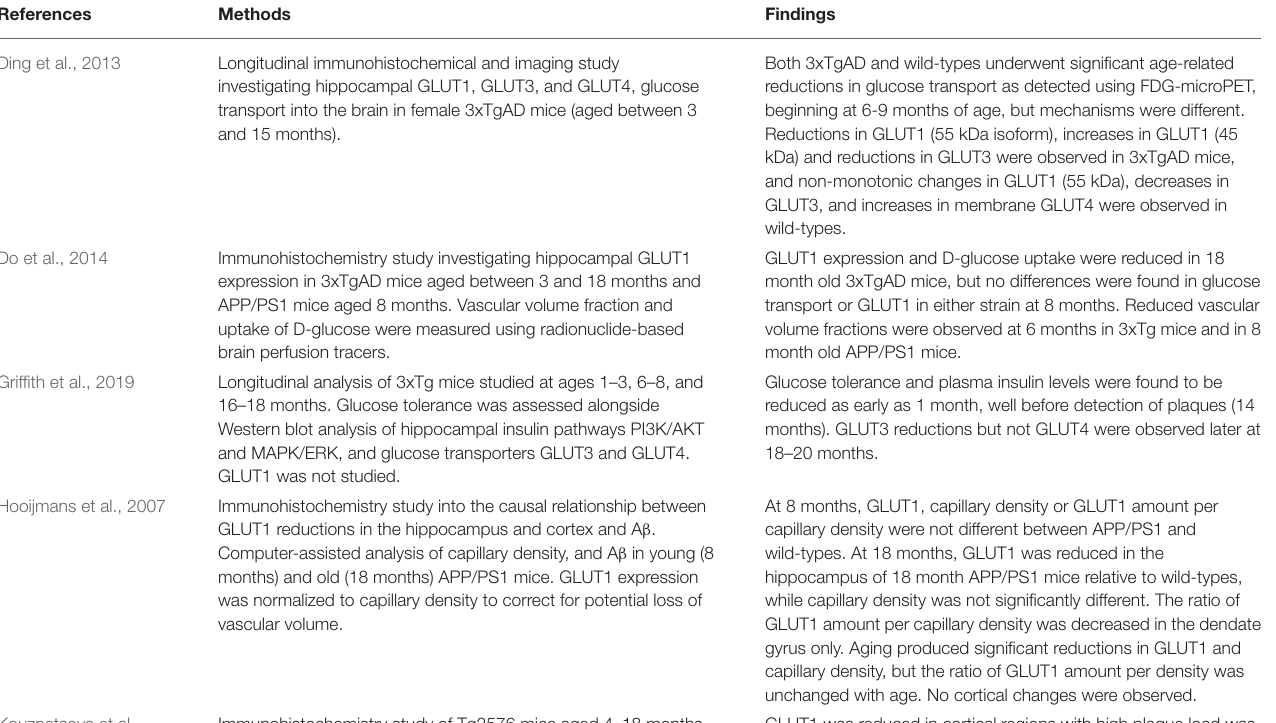
TABLE 3 | A summary of results from rodent post-mortem and tracer